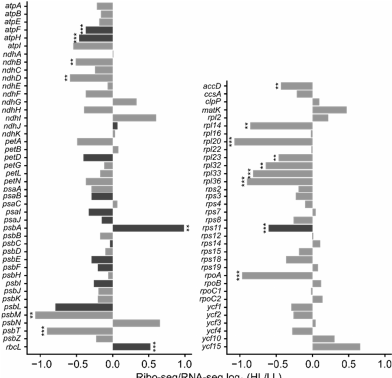
Figure 4. Changes in translation efficiency in response to high light treatment: The translation efficiencies (Ribo-seq/RNA-seq) for all plastid-encoded genes are shown as ratios of the high light (HL) to the low light (LL) scores, expressed as log 2 values. Young leaves of seven-week-old plants were analyzed (as in Figures 1C and 3B). The left panel lists the genes coding for subunits of the photosynthetic complexes, the right panel shows the data for all other genes. Translation efficiency was determined from normalized read counts for the ribosomal footprints divided by those for the transcripts of each coding region (Figure S13). Asterisks indicate statistically significant changes (calculated with RiboDiff; ** = p < 0.01 and *** = p < 0.001). Genes with bars in darker gray had sufficient coverage to permit the analysis of mRNA secondary structure (Figures 1, 3 and 5). If a large proportion of mRNAs is regulated through RNA structural changes similar to what we observed for psbA upon exposure to high light, a correlation would be expected between the changes in translation efficiency and the structural alterations at the start codon and/or Shine-Dalgarno sequence (SD). However, this is not the case for either the start codons (Figure 5(A-1) and Supplemental Figure S15A) or the SDs (Figure 5(A-4) and Supplemental Figure S15D). psbA and rbcL show a higher translation efficiency in light; yet, a clear correlation with mRNA structure changes can only be found for psbA (Figures 1 and 3). Interestingly, these two genes differ strongly regarding the strength of their SD: rbcL possesses a strong SD (hybridization to the anti-SD of the 16S rRNA − 12.98 kcal mol − 1 ), whereas the SD of psbA is much weaker ( − 5.50 kcal mol − 1 ) (Supplemental Table S2). Regarding the strength of their SD, the 16 genes analyzed can be separated into a group with strongly interacting SDs (hybridization to the anti-SD of the 16S rRNA < − 9 kcal mol − 1 ) and a group with weak or no SDs (> − 6 kcal mol − 1 ) (Supplemental Table S2). In our set of 16 genes, there were only two genes without an SD, rps11 and rps12 (coding for the ribosomal proteins uS11c and uS12c, respectively). Therefore, SD-independent translation could not be investigated specifically, and these two genes were included in the group with weak or no SDs as appropriate. Using these two groups of genes for an analysis of the start codons, we still did not observe a significant correlation between the changes in SHAPE reactivities and the change in translation efficiency (Figure 5(A-2,A-3) and Supplemental Figure S15B,C). In contrast, there was a clear difference between the groups regarding the structure at the SD. Genes with weak SDs showed a statistically significant correlation between the change in translation efficiency and the change in SHAPE reactivities in the SDs (Figure 5(A-6,B) and Supplemental Figure S15F). No such